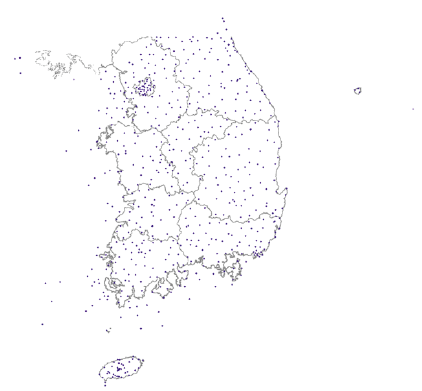
Figure 5: Locations of